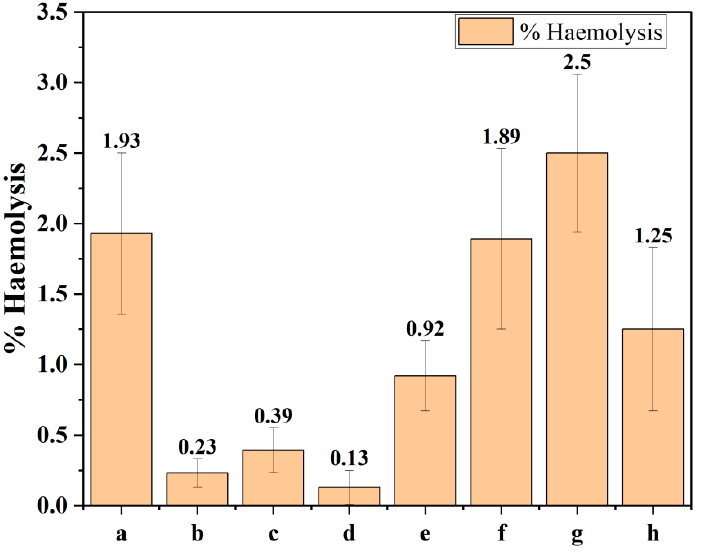
Figure 18. Hemolysis assay: (a) PLA, (b) PEG, (c) PLA-PEG, (d) PLA-PEG-heparin, (e) LDH (100 mg/mL), (f) LDH (200 mg/mL), (g) LDH (500 mg/mL), and (h) BCA-LDH-C (500 mg/mL). The optical images of the supernatant of each sample during hemolysis assay are represented in Figure 19. The intensity of color is the measure of degree of hemolysis that occurred in the presence of the sample. The positive control has the highest percentage of hemolysis (supernatant appears darker), and the negative has the least (supernatant appears clear). Samples A, B, and C represent the degree of hemolysis of LDH (200 mg/mL), LDH (500 mg/mL), and BCA-LDH-C (500 mg/mL), respectively. D, E, F, and G represent the percentage hemolysis of PLA, PEG, PLA-PEG, and PLA-PEG-heparin, respectively. A negligible percentage of hemolysis was observed from the PLA-PEG and PLA-PEG-heparin when compared to PLA alone. These results are in line with the quantitative hemolysis assay.